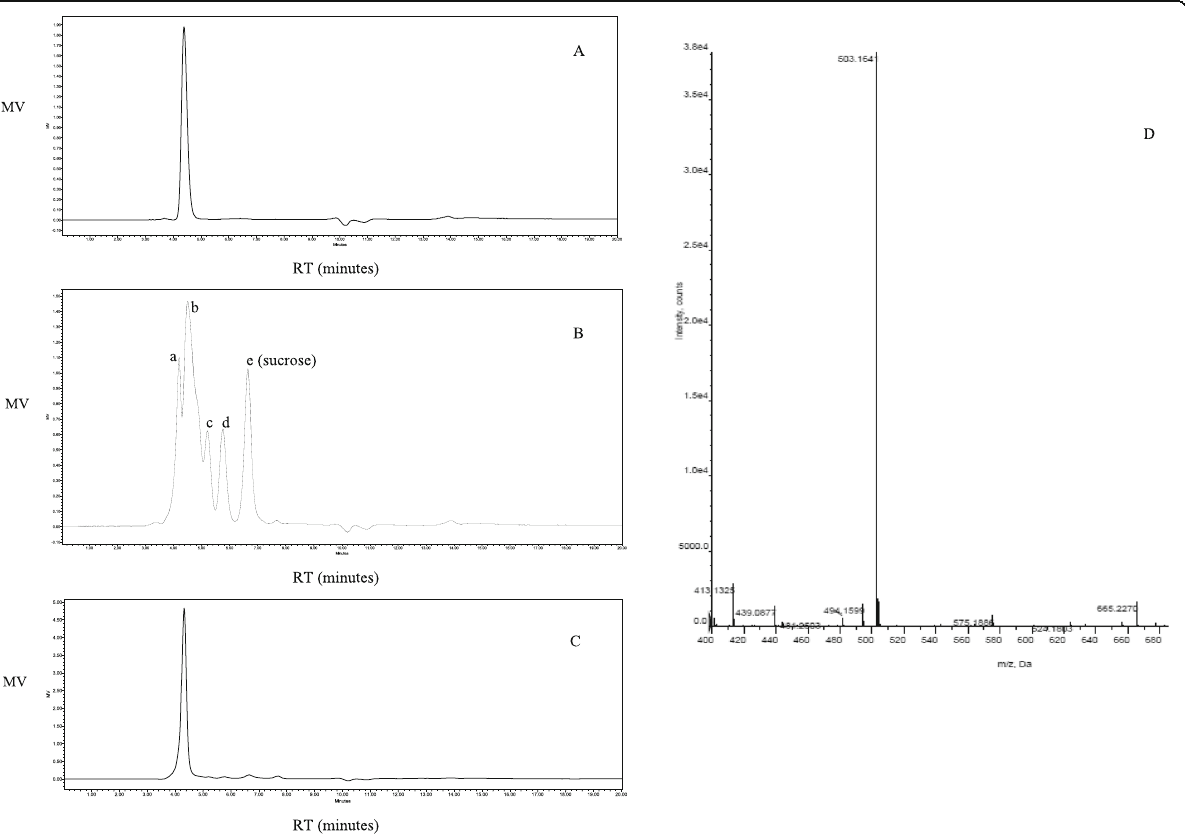
Fig. 2 HPLC chromatograms and mass spectra of inulin. a 0.25 mg/mL commercial inulin (CI) from chicory root; b 1 mg/mL primary purified inulin extract (PPIE) from Jerusalem artichoke (JA); c 1 mg/ml secondary purified inulin extract (SPIE) from JA; and d Partial mass spectra of